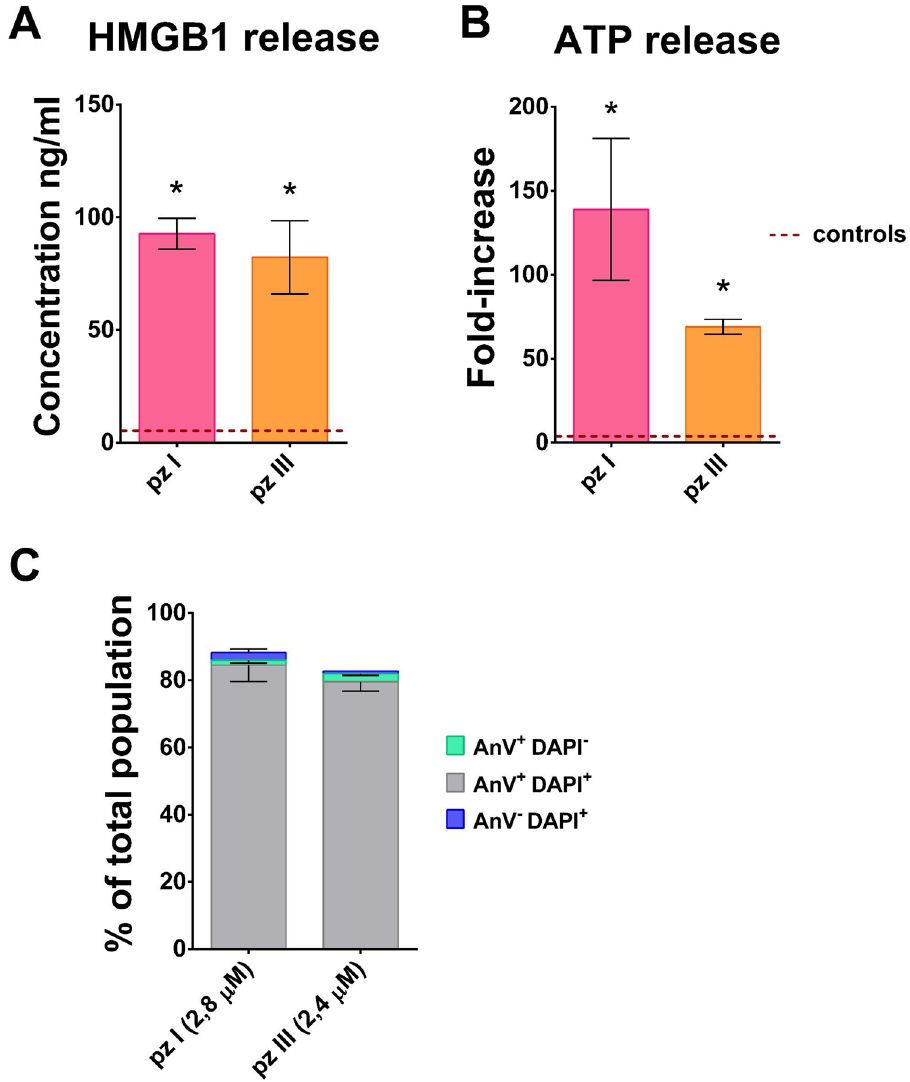
Figure 4. Cell death induced in cancer cells by pz I-PDT or pz III-PDT is associated with HMGB1 and ATP release. ( A ) HMGB1 release. Fibrosarcoma MCA205 cells were recovered for 24 h after treatment with 2.8 µM of pz I-PDT or 2.4 µM of pz III-PDT (IC 90 ) or without treatment (live). HMGB1 was measured in the supernatants. HMGB1 values represent the mean values of five independent experiments. Statistical